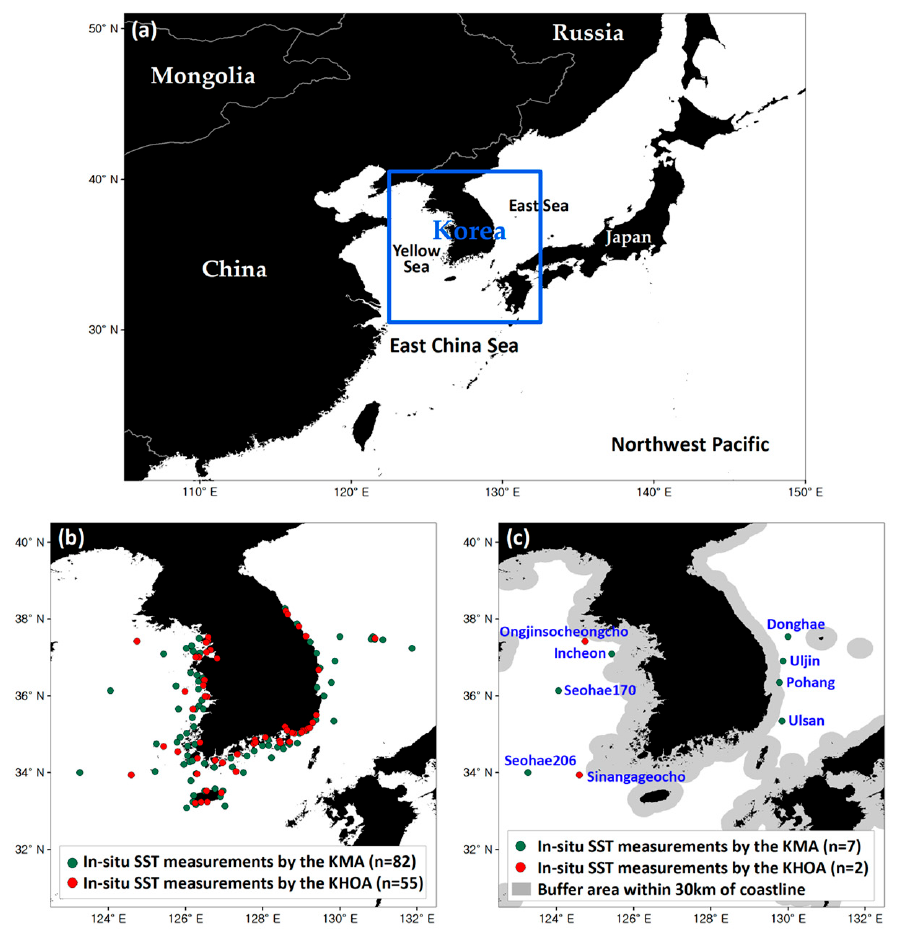
Figure 1. ( a ) A map of East Asia including Korean Peninsula, where the blue rectangle indicates the study area (30.5–40.5 ◦ N and 122.5–132.5 ◦ E): ( b ) 137 stations for in situ SST measurements by the Korea Meteorological Administration (KMA) and the Korea Hydrographic and Oceanographic Agency (KHOA) used as reference data for the validation of GK2A SST gap-filling and ( c ) nine stations for the performance evaluation, particularly for the far seas outside 30 km from the coastline.